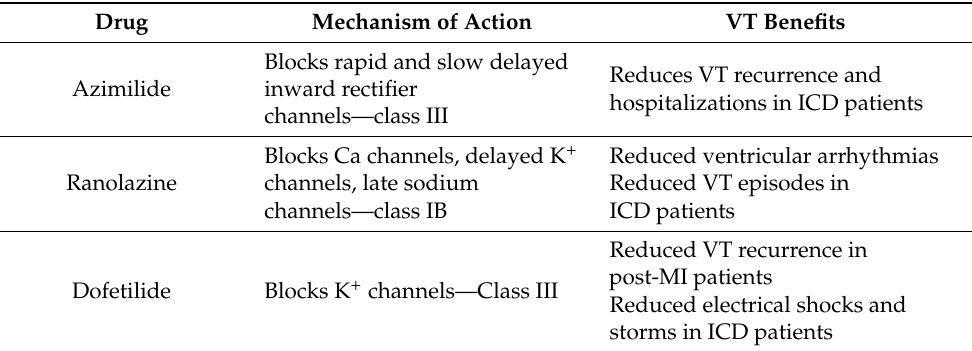
Table 5. New pharmacologic therapies for VT. Drug Mechanism of